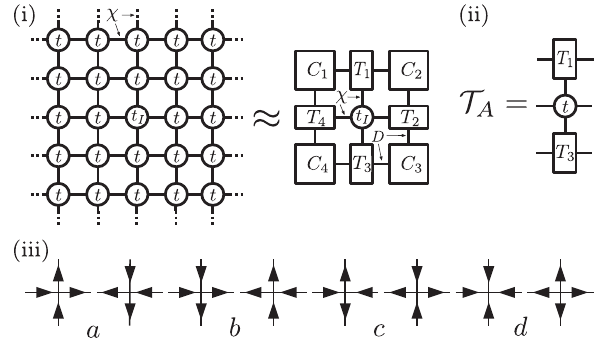
FIG. 7. (i) Visualization of the corner transfer matrix renorm- alization method where the environment of a single site, marked as t here, of infinite 2D lattice is approximated by a combination I of finite size (finite D ) tensors T and C . (ii) Definition of column- to-column transfer matrix used in this work. In panel (iii) we show allowed configurations and their Boltzmann weights in the 8-vertex model. They are combined into one tensor t in (i) and (ii), with χ ¼ 2 being a number of possible states of local variable living on the edges of the